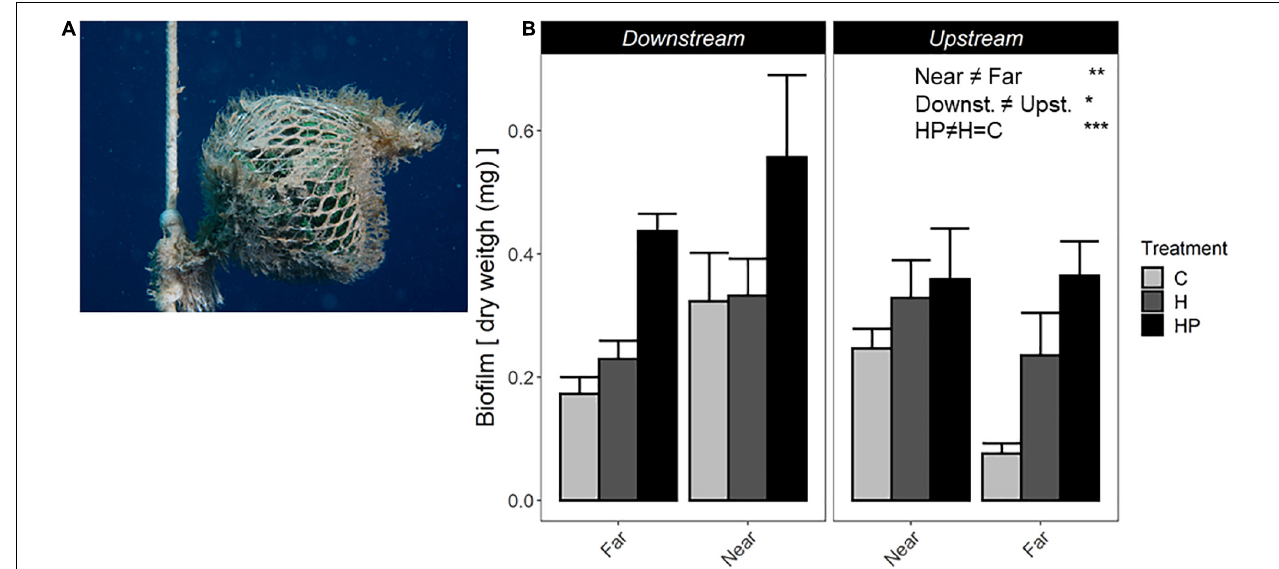
FIGURE 2 | (A) Fouling community on an AC after 15 experimental days. (B) Biomass of sessile colonising community, including biofilm and small hydroids, expressed as dry weight (mg). ACs are represented as ACs containing habitat and feed pellets (HP), only habitat (H) or control (C). Significant GLM results are expressed as * p < 0.05; ** p < 0.01; and *** p <